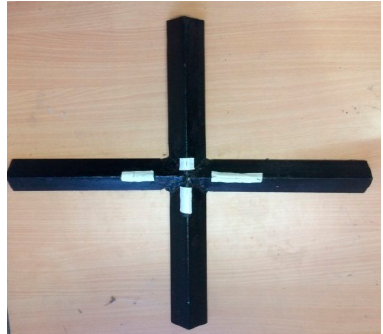
Figure 3. Experimental setup for the fundamental torsional frequency.